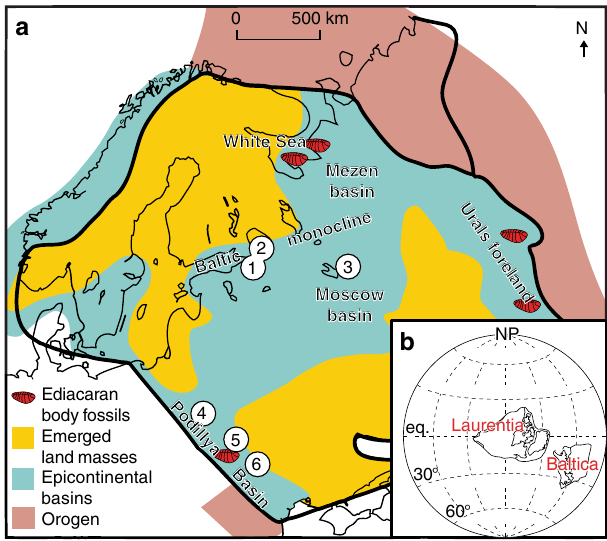
Fig. 1 Paleogeography and known Ediacara biota fossil occurrences across Baltica. a Paleogeographic reconstruction of Baltica during the late Ediacaran (modi fi ed from Sliaupa et al. 83 ) with studied drill cores and outcrops shown (1 — Utkina Zavod; 2 — Lugovoe; 3 — Gavrilov-Yam-1 in Russia; 4 — 4504, 4529, and 4592 cores from the Volyn Basin, Ukraine; 5 — 3628 core from the Podillya Basin, Ukraine; and 6 — outcrops 16PL from the Podillya Basin, Moldova). b Global reconstruction of Laurentia and Baltica at ~550 Ma, modi fi ed from Fedorova et al. 84